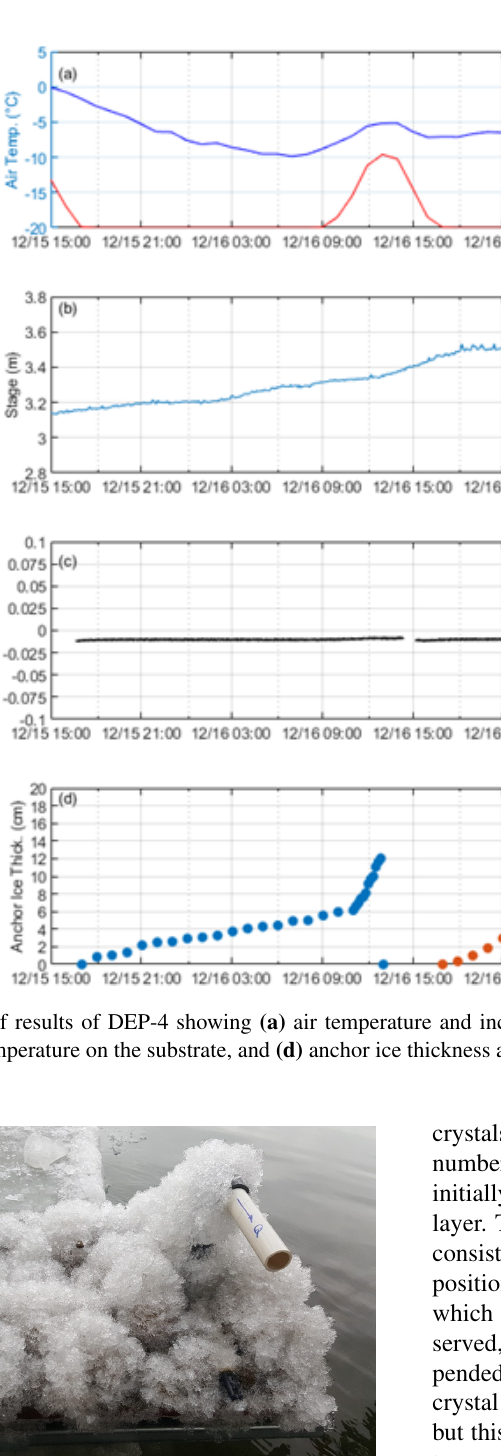
Figure 9. Anchor ice formation on the artificial substrate after the instrument’s retrieval on 12 November